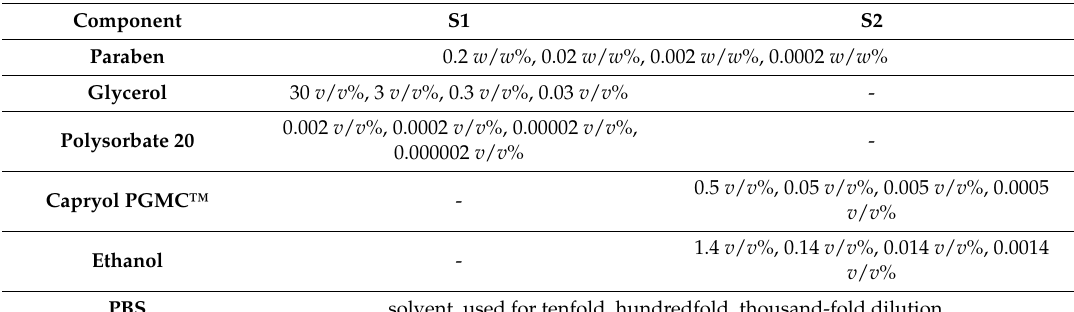
Table 1. Composition of test solutions for cytotoxicity tests.